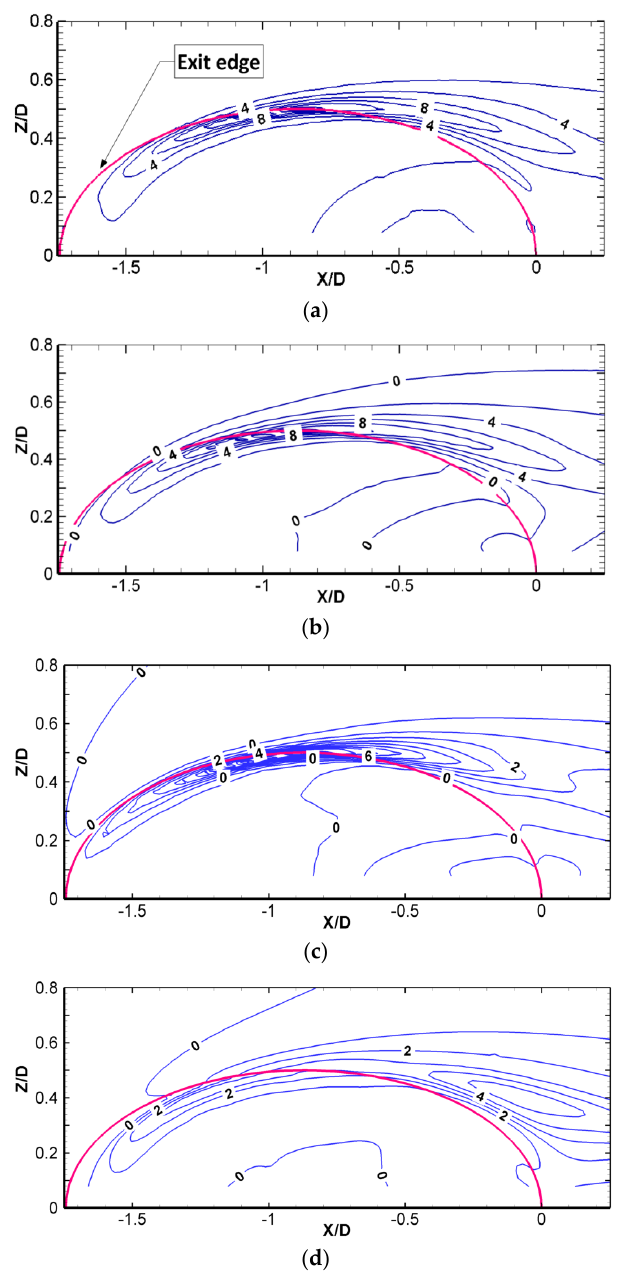
Figure 6. Contours of vorticity and velocity gradients for the baseline (Case 1), at Y/D = 0.1 for Br = 1. ( a ) ‖ 𝜔⃗⃗ ‖ ; ( b ) ω x ; ( c ) − ∂v/∂z ; ( d ) ∂w/∂y .